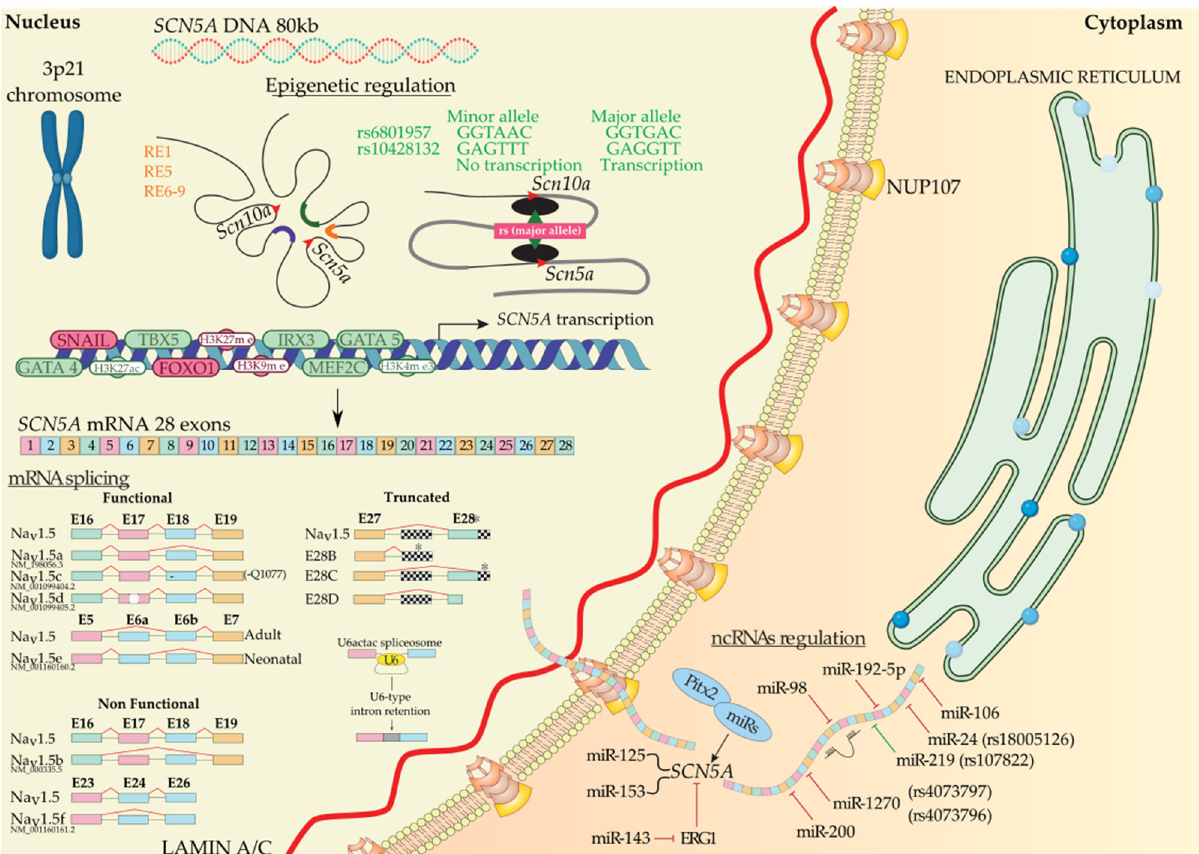
Figure 1. SCN5A biosynthesis: chromosomal localization, gene transcriptional activation modulated by regulatory elements, transcription factors, histones, and SNPs. Functional, non-functional, and truncated isoforms derived from mRNA splicing, mechanism of the U6-type intron retention, and post-transcriptional regulation mediated by ncRNAs. Alternative exon sequences, intronic or exonic sequences outside the open reading frame (squared), and stop codons (asterisks) are